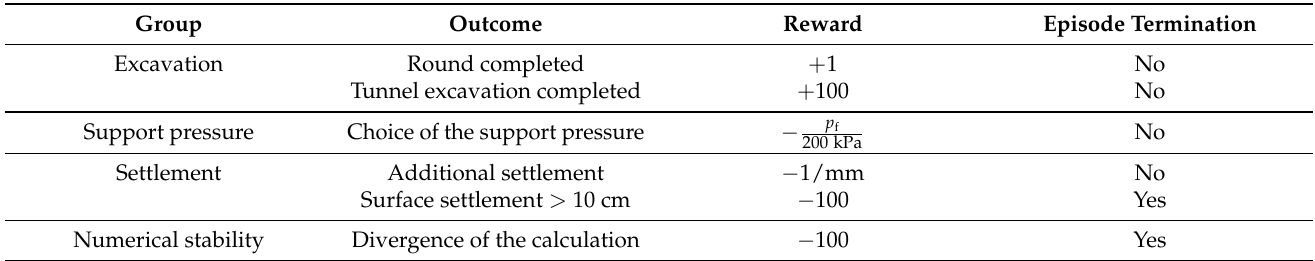
Table 1. Summary of the rewards associated with the outcomes of the